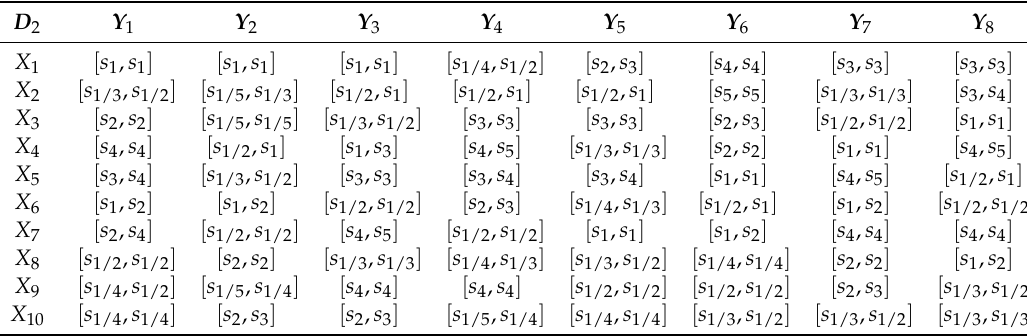
Table A2. Linguistic evaluation information matrix of D 2